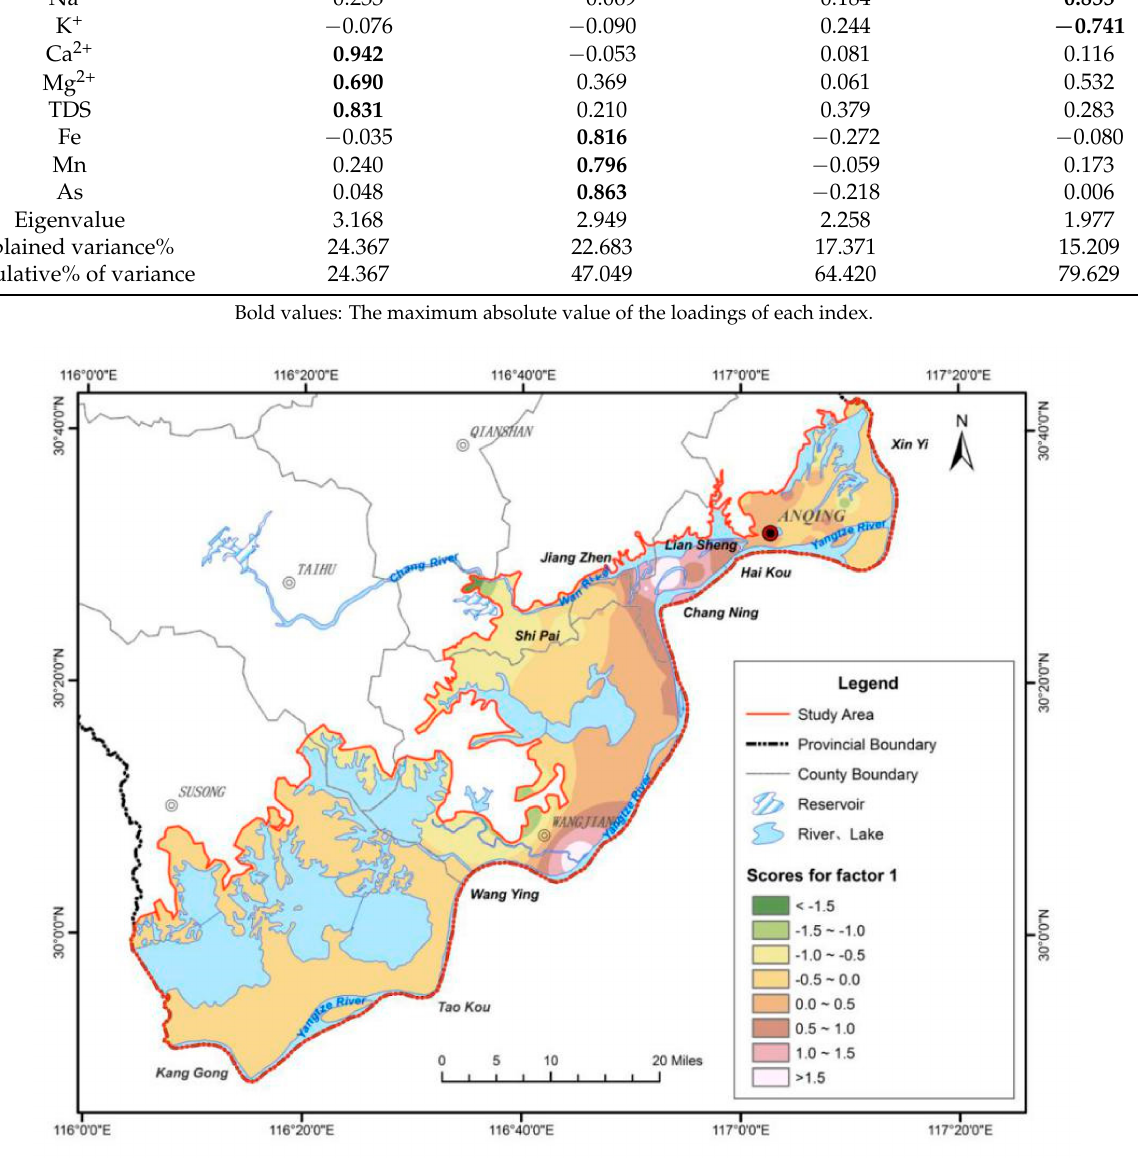
Figure 10. Distribution of scores of factor 1 for confined